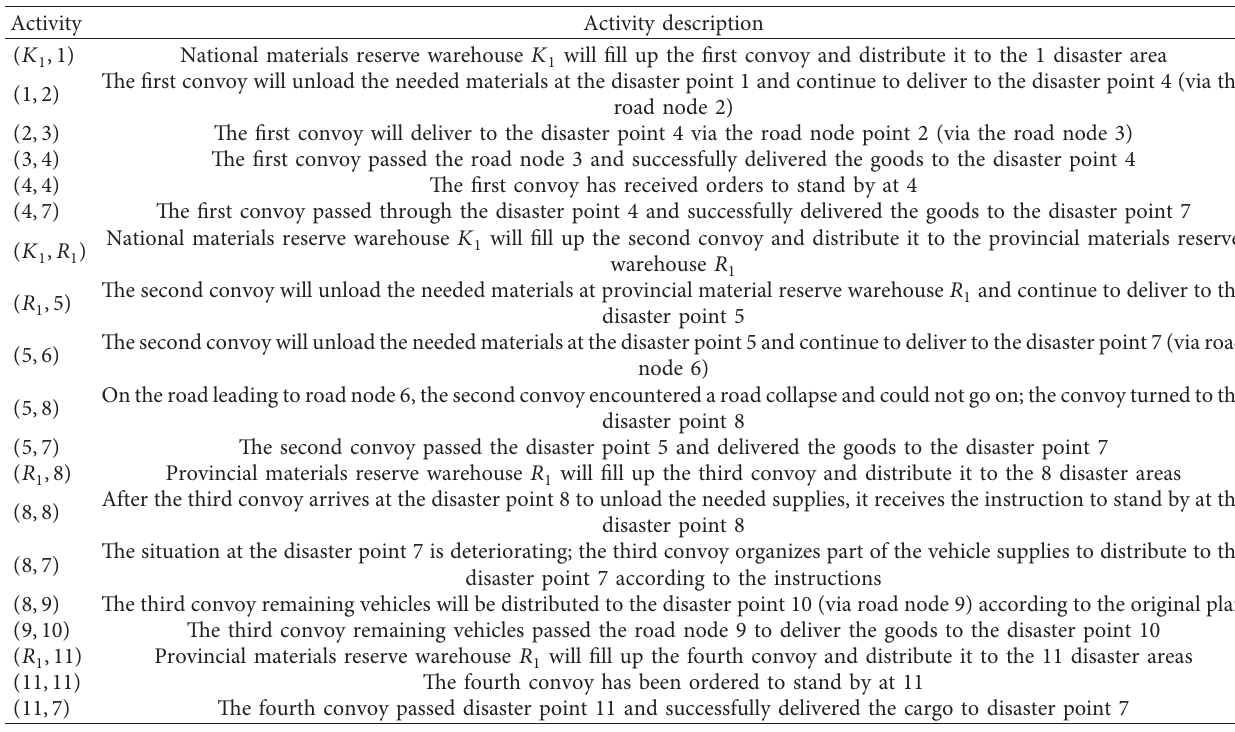
Figure 1: Network model of emergency transshipment and distribution from each disaster site to disaster point 7. Table 1: The meaning of all the activities of the random network of emergency transport and distribution of each disaster point to the disaster point 7.